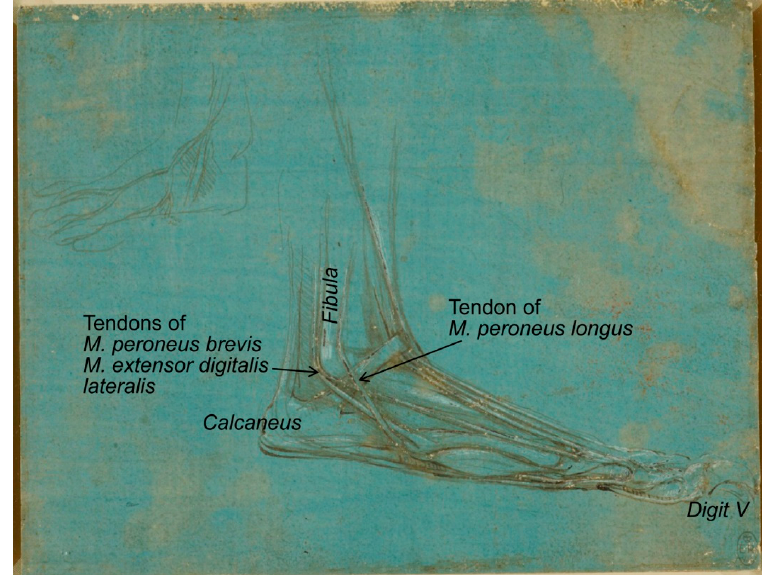
Figure 4. Bear’s foot series—Number 3. Bear distal right pelvic limb/ pes , lateral view. A bear’s foot c.1488–1490. Modified from www.rct.uk/collection/912374 (Royal Collection Trust [3]). This image is